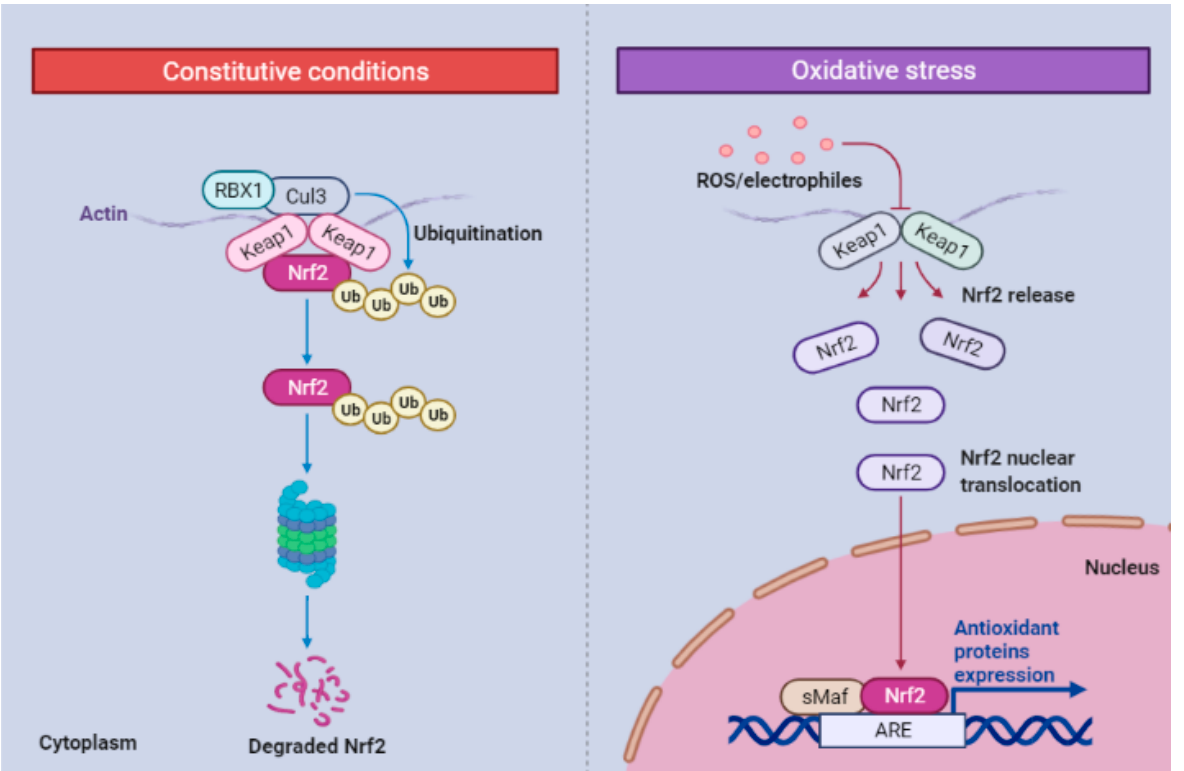
Figure 2. Schematic representation ofNrf2regulation viaKEAP1 Pathway.Nrf2 is consistently ubiquitinated by KEAP1 and destroyed in the cytosol proteasome at normal conditions. During stress, the KEAP1-Nrf2 connection is disrupted, allowing free NRF2 to translocate into the nucleus. Nrf2 then forms heterodimers with sMaf and binds to ARE sites in antioxidant and detoxification genes’ regulatory regions. Nrf2;(nuclearerythroid2likefactor-2); KEAP1(Kelch-likeECH-associatedprotein1); AR (antioxidant response element);sMafs;(small musculoaponeuroticfibrosarcoma oncogene family).